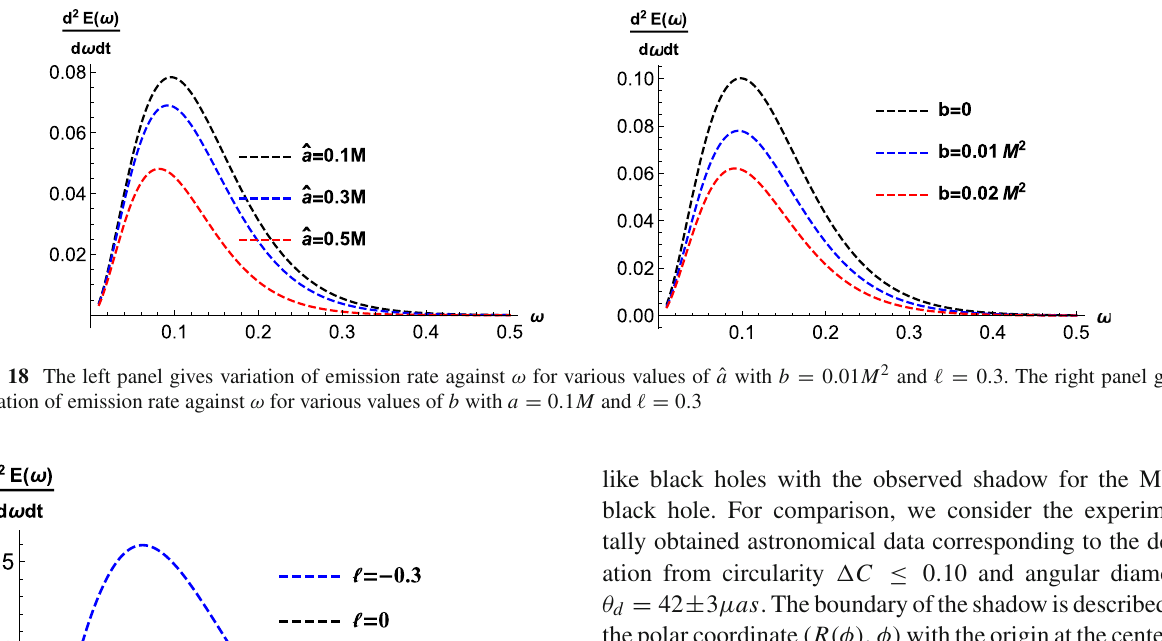
Fig. 17 The left one shows variation of R s for various values of ˆ a with (cid:2) = − 0 . 2 and θ = π/ 2. The right one shows variation of δ s for various values of ˆ a with (cid:2) = − 0 . 2 and θ = π/ 2